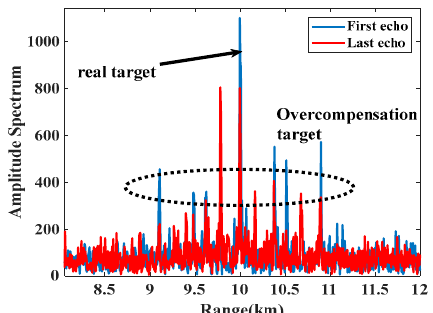
Figure 12. Pulse compression results after compensating the MTRC based on the improved Key- stone algorithm.